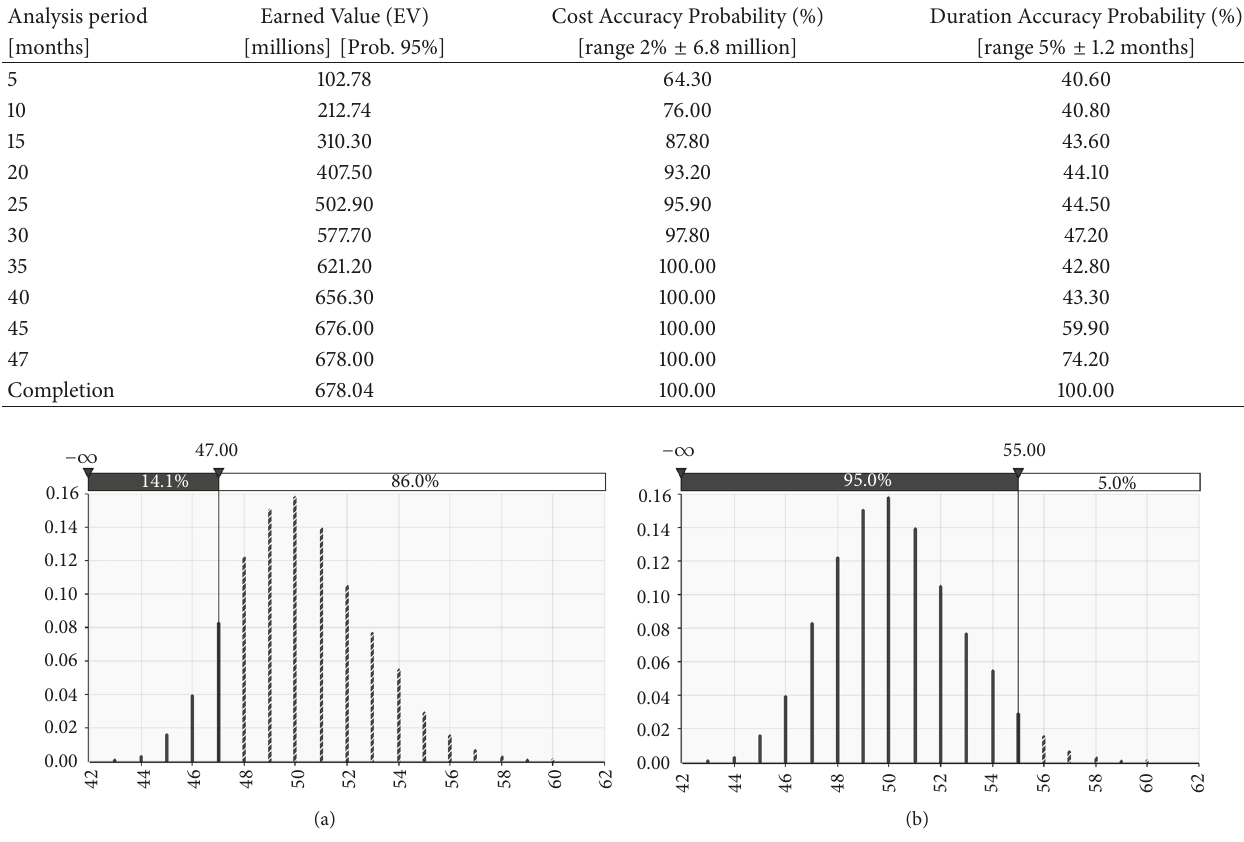
Figure 5: Relative frequency histograms of the duration of the Sopladora project. (a) Duration probability equal to or less than 47 months (SAC). (b) Duration calculated with 95% probability equal to 55 months.